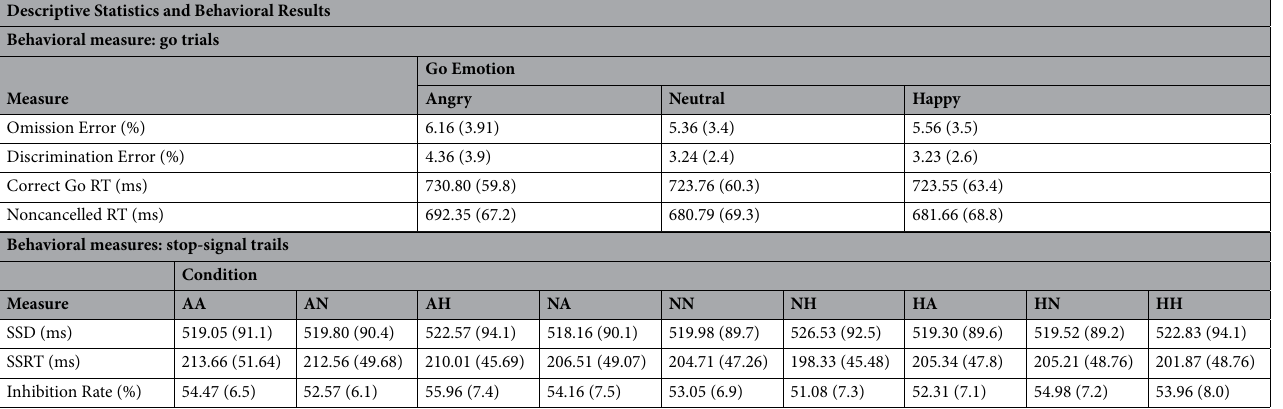
Table 1. All values represent mean (standard deviation). SSD = stop-signal delay; SSRT = stop-signal reaction time; RT = reaction time; Noncancelled RT: RT from those trials where the participant could not withhold their response; AA, AN, AH; NA, NN, NH; HA, HN, HH respectively correspond to angry-angry, angry-neutral, angry-happy; neutral-angry, neutral–neutral, neutral-happy; happy-angry, happy-neutral, happy-happy. Here first emotion is the emotion of the go signal and the second emotion is the emotion of the stop